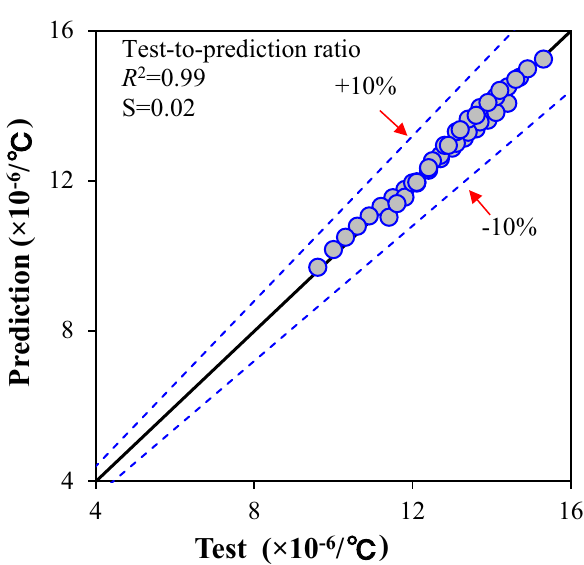
Fig. 8 Comparisons of average linear thermal expansion coefficient a m between tests and